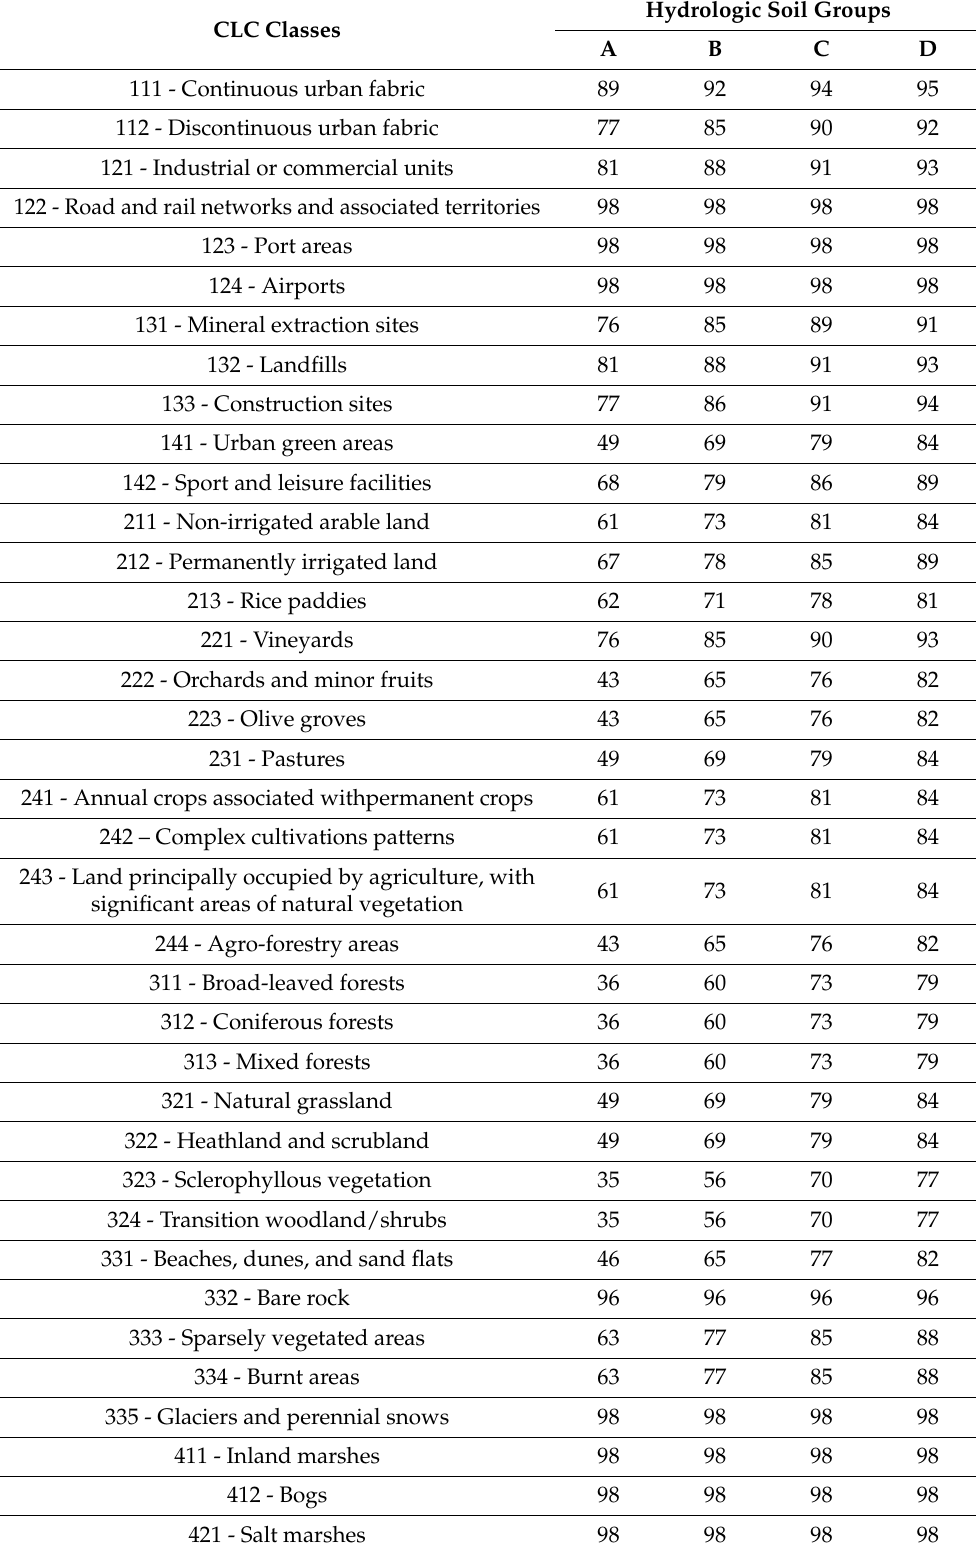
Table A1. Curve number values (average wet condition) assigned to III level Corine land-cover (CLC) classes. Source: Castelli F.